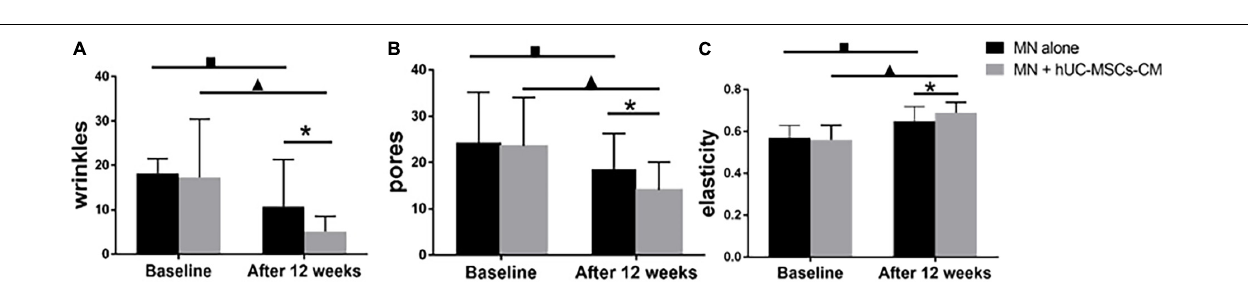
FIGURE 4 | Objective non-invasive skin texture measurements: (A) wrinkles; (B) pores; (C) elasticity. MN: microneedling; hUC-MSCs-CM: human umbilical cord-derived mesenchymal stem cells conditioned media. * P < 0.05, post-treatment comparison between MN alone and MN plus hUC-MSCs-CM; (cid:78) P < 0.05, pre-treatment and post-treatment in MN plus hUC-MSCs-CM; (cid:4) P < 0.05, pre-treatment and post-treatment in MN alone.